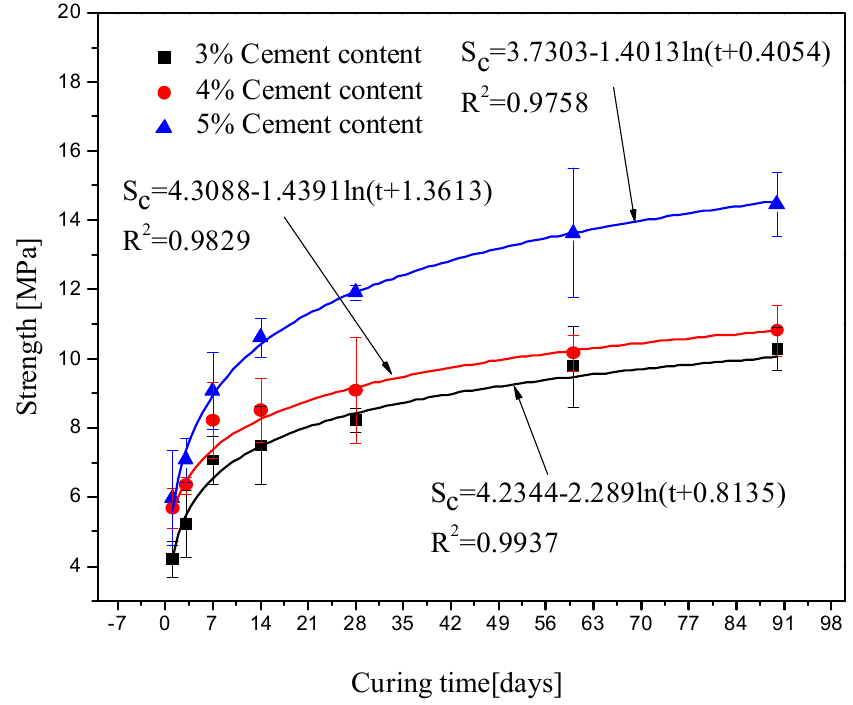
Figure 2. Variation patterns for the unconfined compressive strength with the curing time and cement cement content.